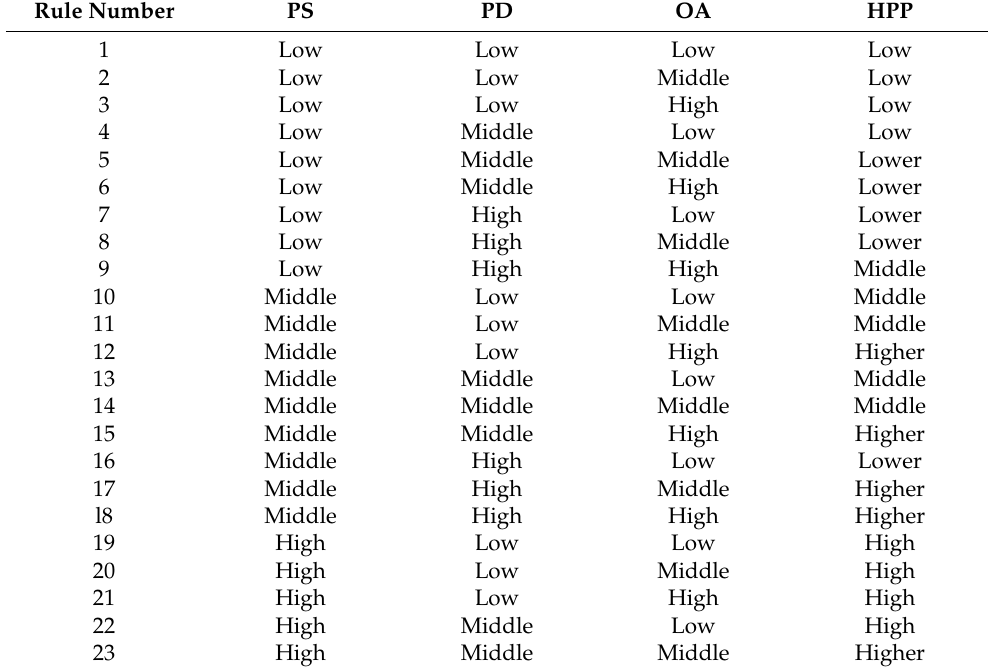
Table 1. Fuzzy logic